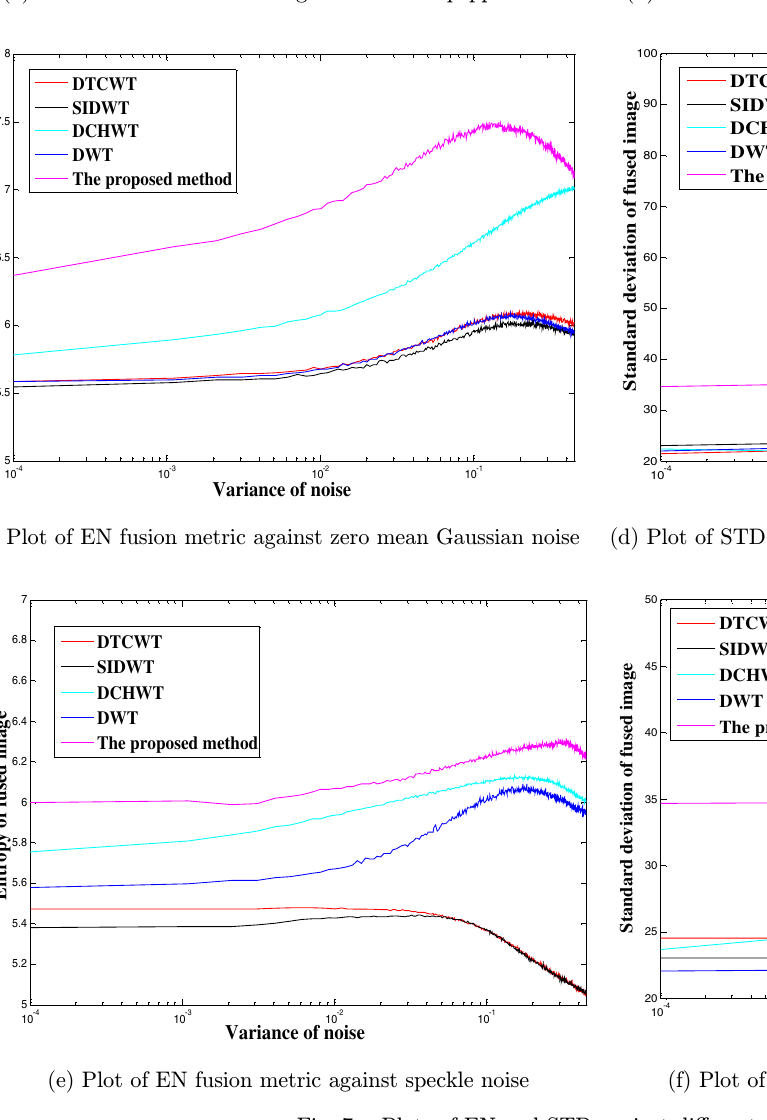
(a) Plot of EN fusion metric against salt and pepper noise (b) Plot of STD fusion metric against salt and pepper noise